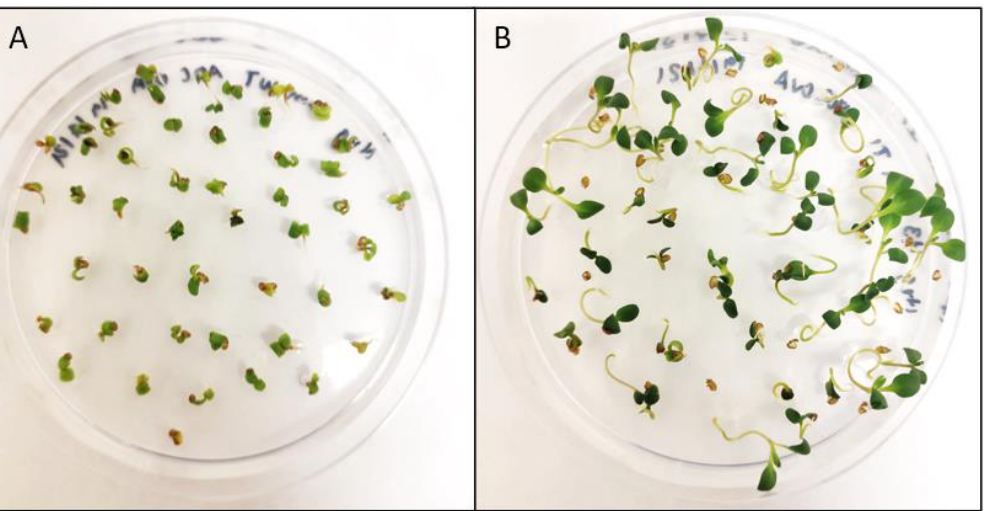
Figure 4. Selection of transgenic Camelina on MS media containing 22.5 mg/L Hygromycin. Pictures were taken after 14 days. ( A ) WT Camelina sativa ( B ) Segregating T2 generation of pH2GW7 transformants (hygromycin-resistant).